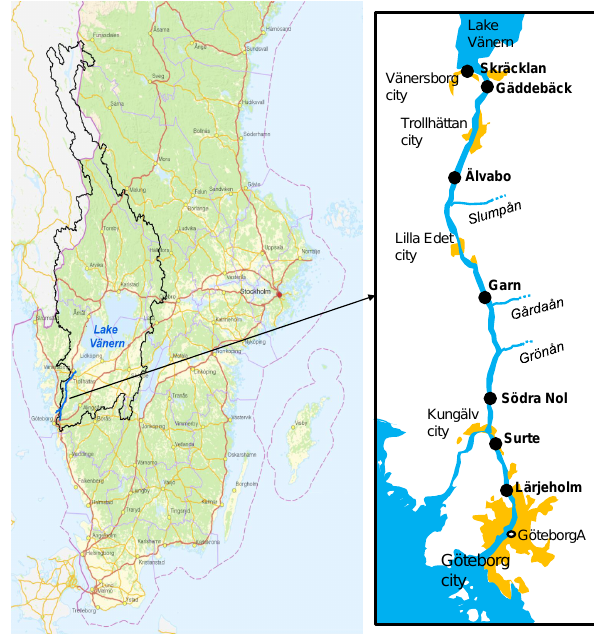
Fig. 2. Net sediment budget for the river G¨ota ¨Alv downstream from Lake V¨anern (Rydell et al.,